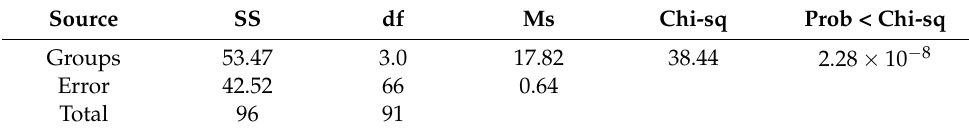
Table 9. The result of the Friedman M test.